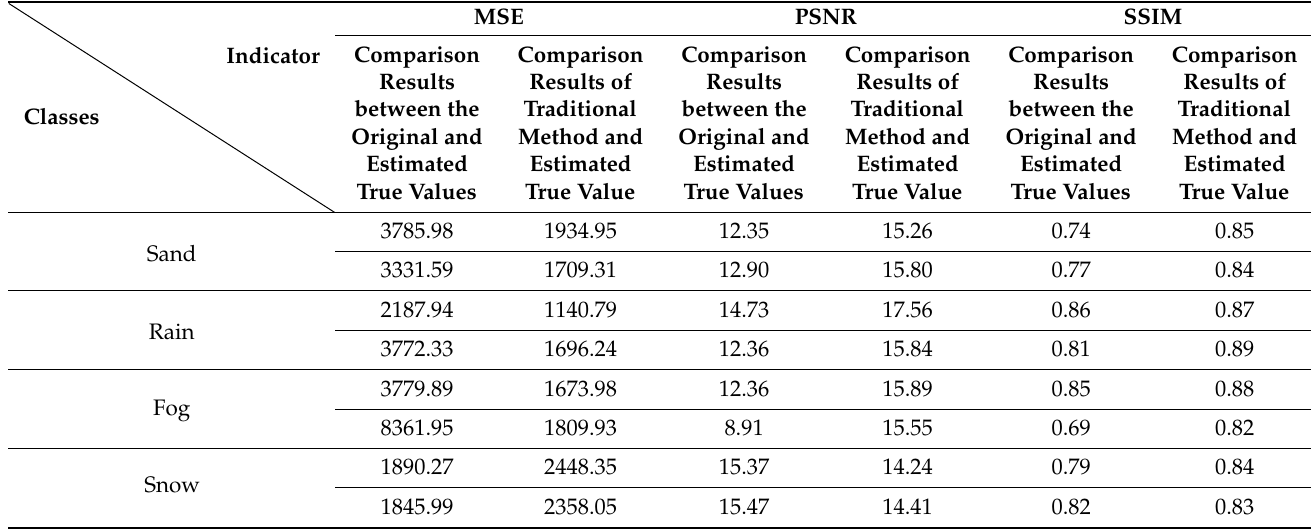
Table 3. Results of evaluation metrics between different images and estimated true